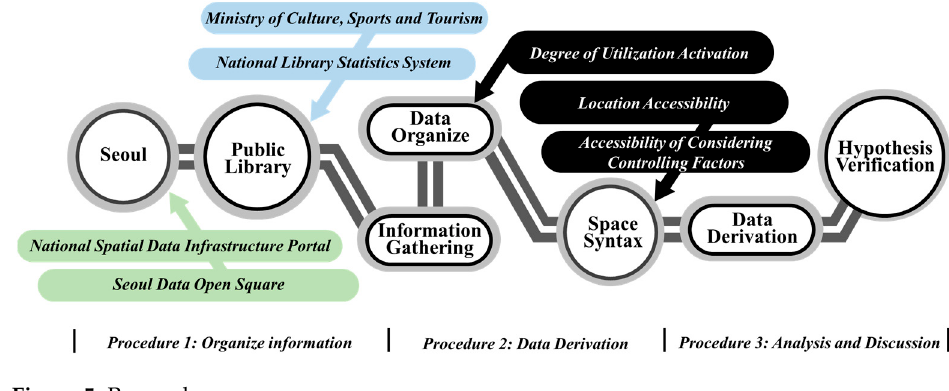
Figure 5. Research process.